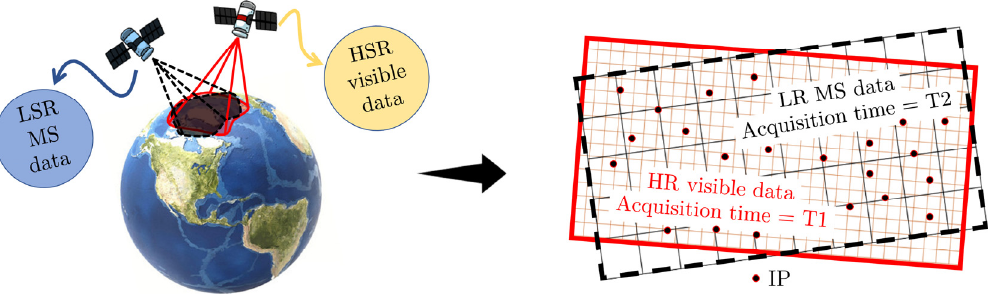
Figure 1. Conceptual illustration of the mismatch between data sources due to the acquisition from di ff erent instruments. An IP is robust to the probable mismatches and has the same landcover type in both images.